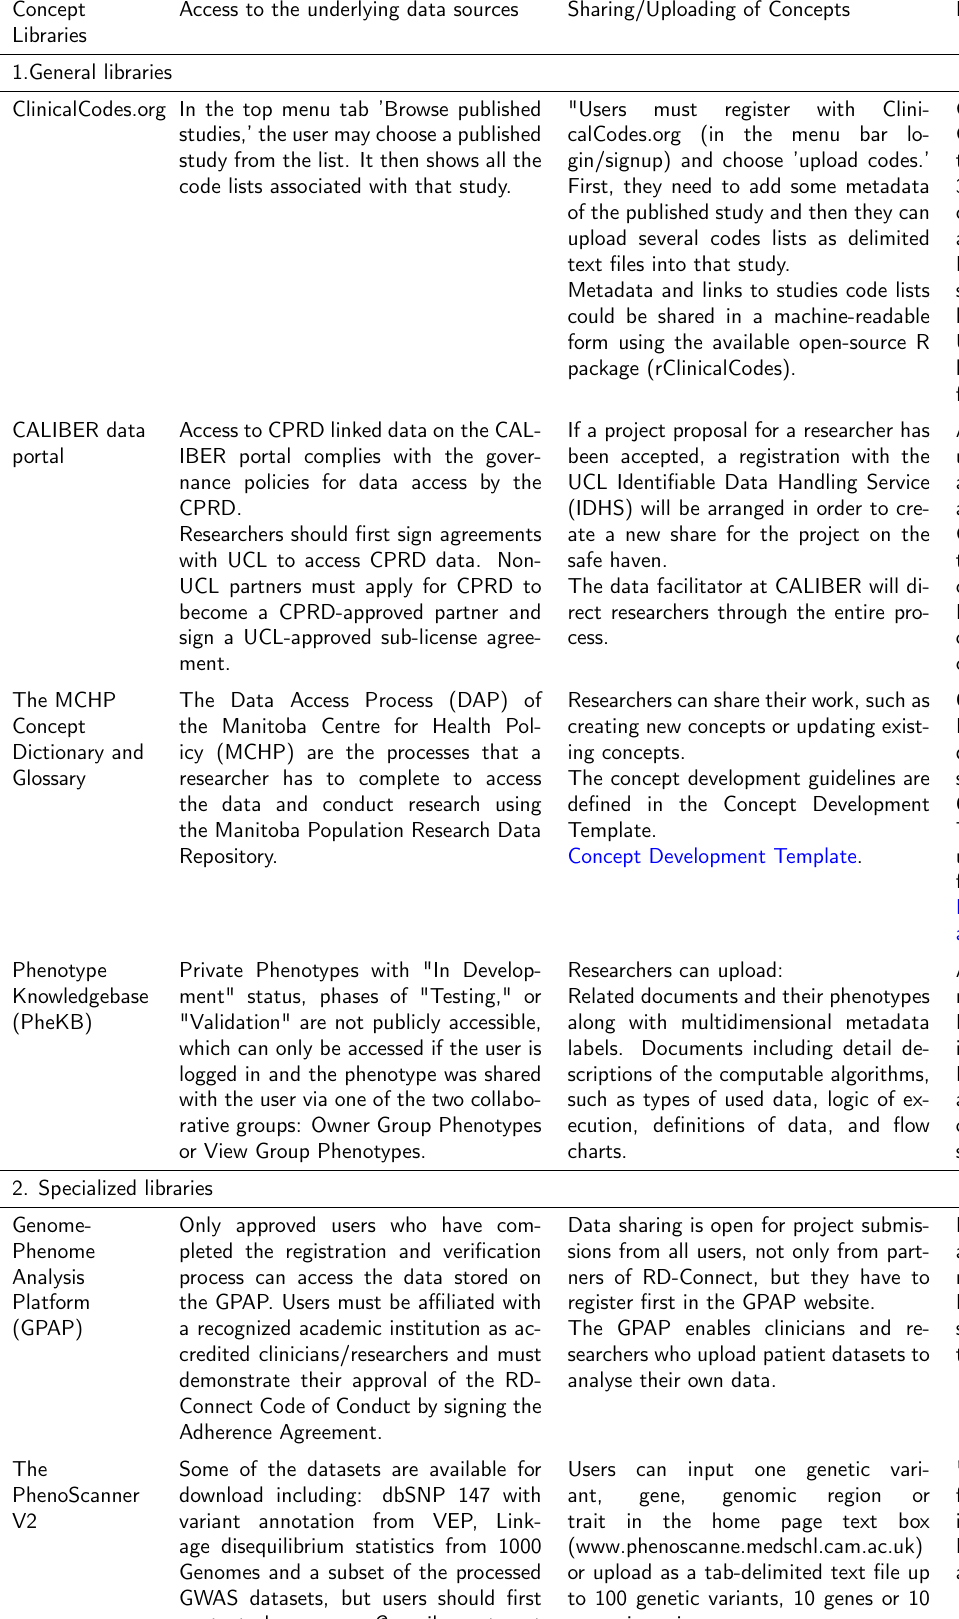
Table 2: Some of the characteristics of the seven concepts